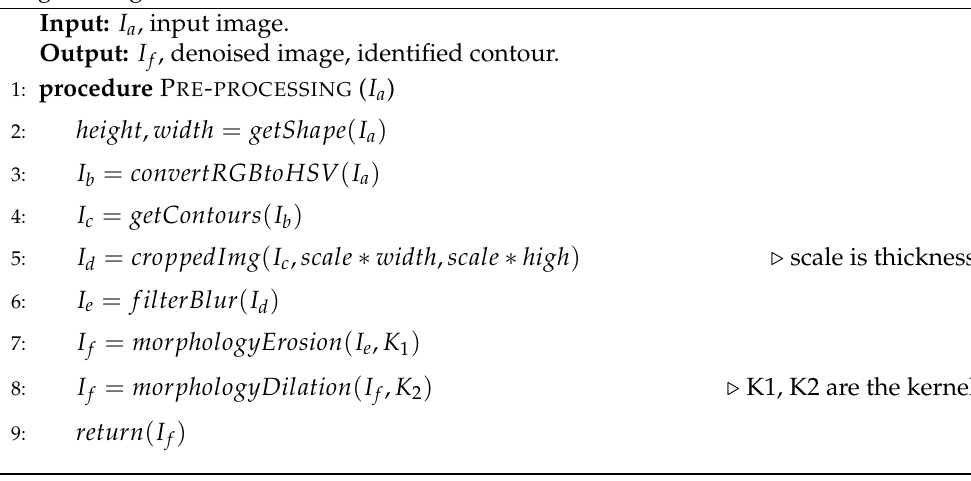
Algorithm A1 Proposed method to remove noise, showing lines 1–9 , corresponding to the images in Figure 3b.